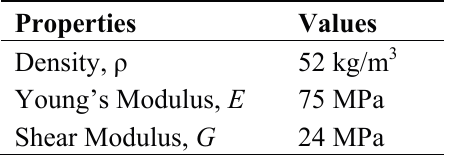
Table 1. Material properties of Rohacell ® 51 RIMA foam [12].